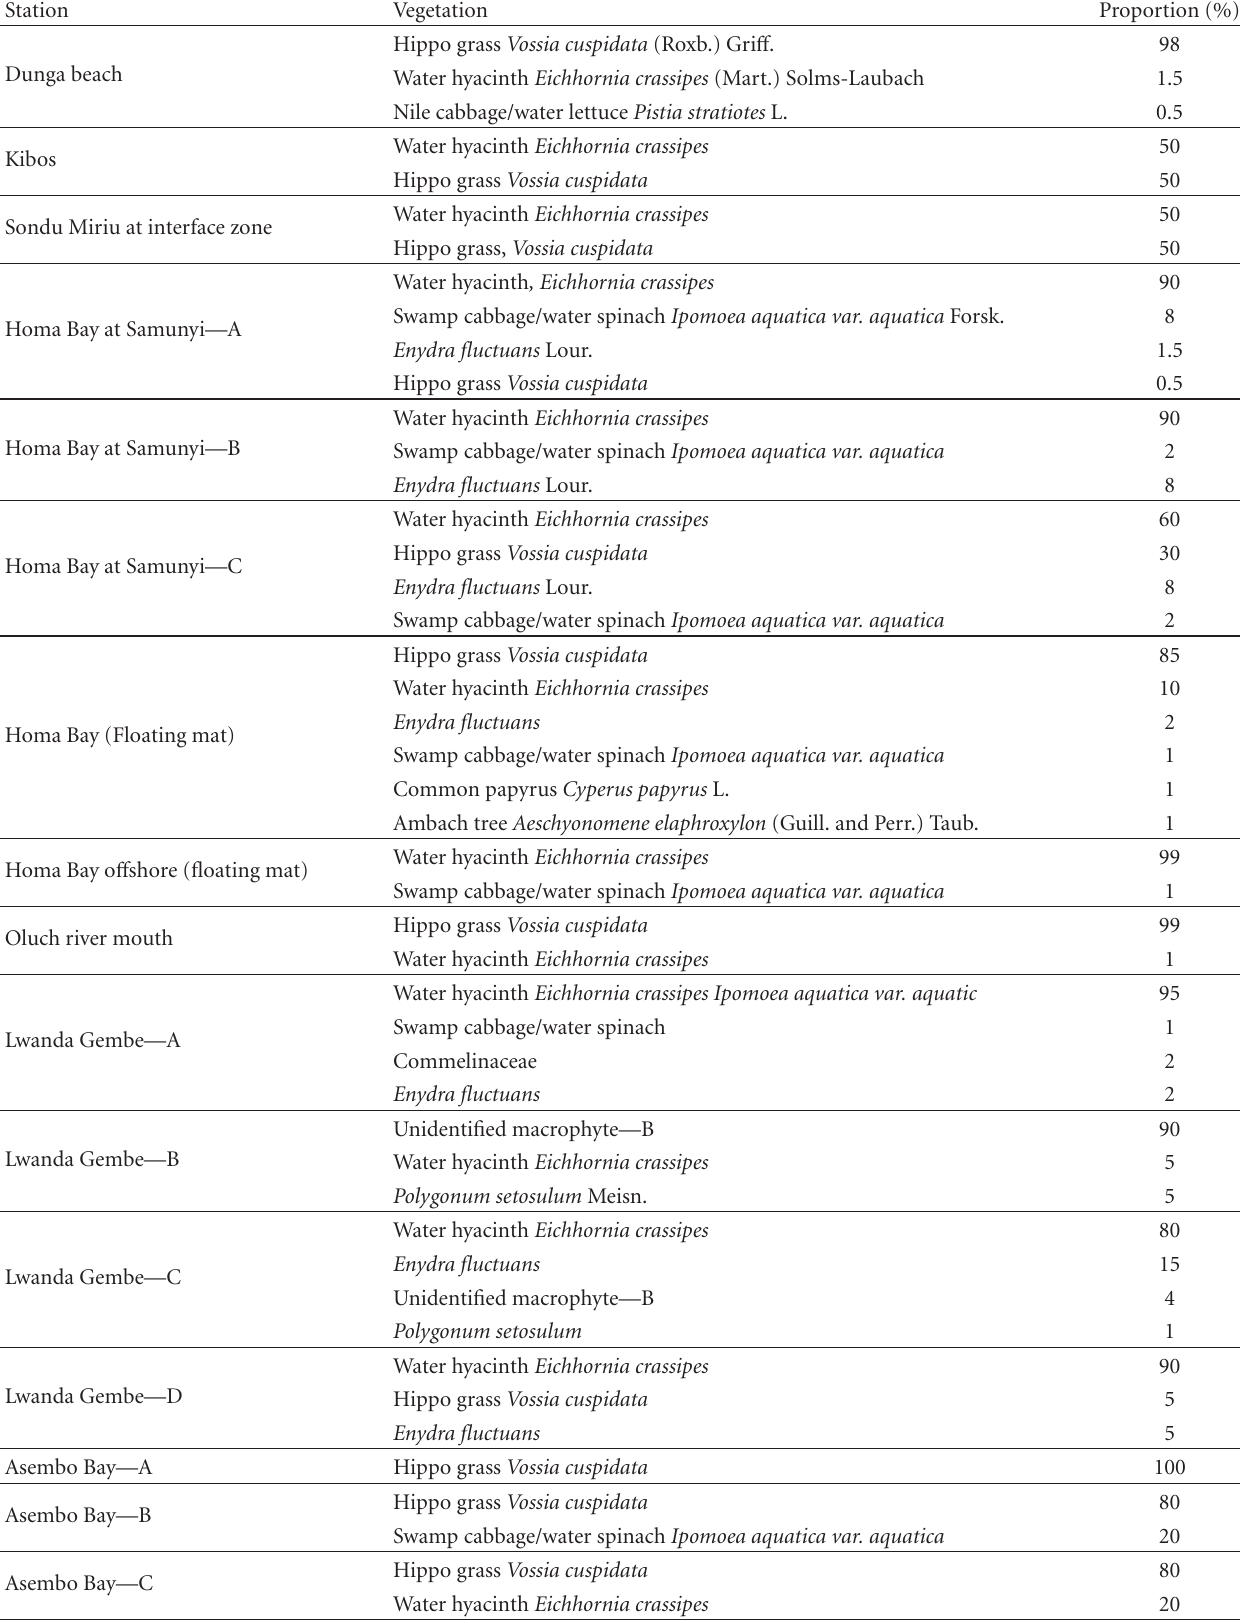
Table 2: An inventory of the macrophyte vegetation and the proportions (%) observed at the sampled sites.